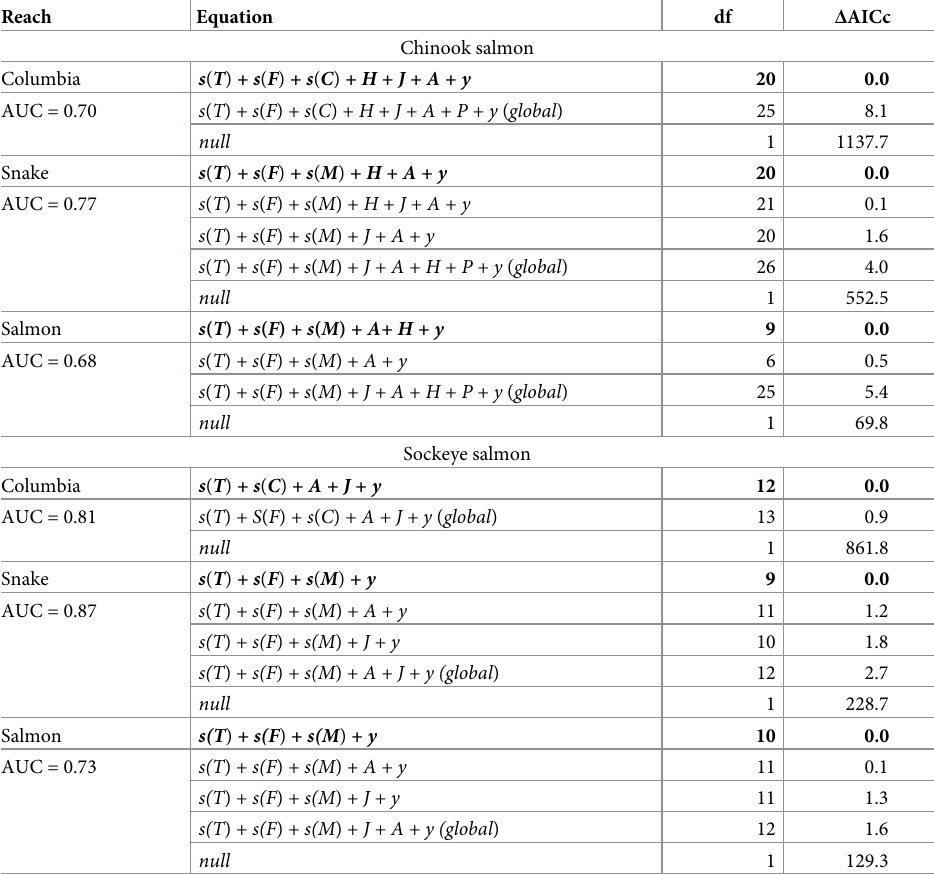
All combinations of variables in the global models were compared, and are shown with the null model and all models with Δ AICc < 2. We selected the simplest model with Δ AICc < 2, shown in bold. The area under the curve (AUC) is also shown for each